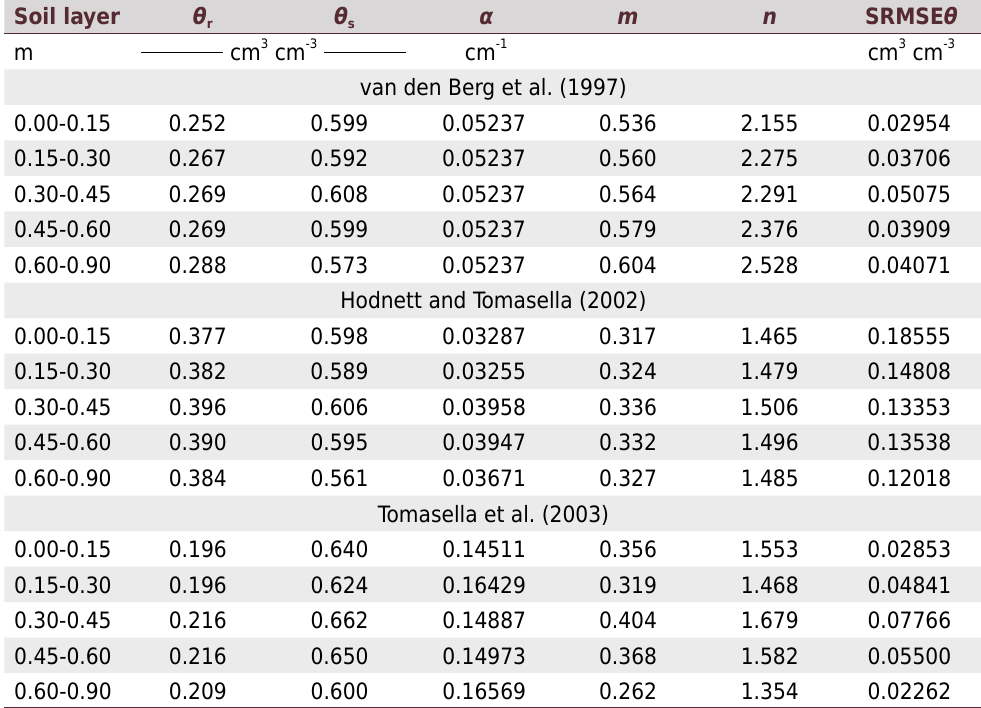
Table 4. Parameters of the hydrodynamic characteristics h ( θ ) of the soil profile, estimated with the pedotransfer functions shown in table 2 Soil layer θ r θ s